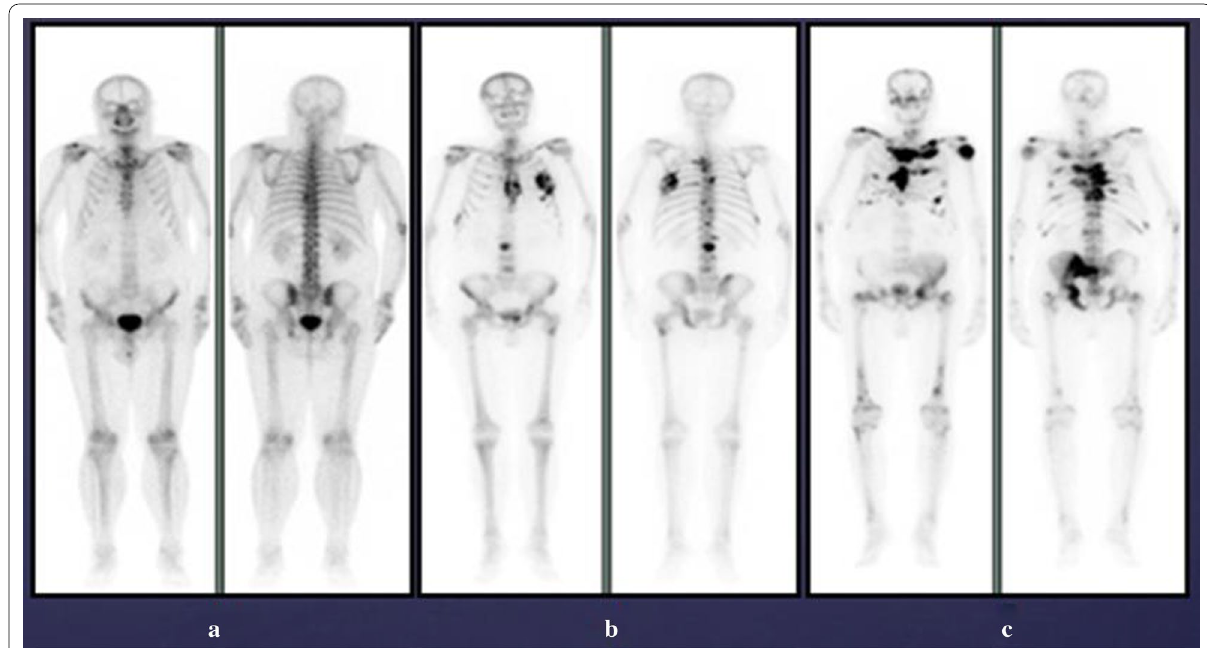
Fig. 1 Bone scintigraphy images of three prostate cancer patients at different stages. a: An example patient without bone metastases; free PSA: 2.53 ng/ml, total PSA:17.54 ng/ml, free/total PSA ratio: 0.144, ALP: 43 U/L, b: An example patient with numerous metastases; free PSA: 3.11 ng/ ml, total PSA:18.30 ng/ml, free/total PSA ratio: 0.169, ALP: 114 U/L. C: An example patient with multiple metastases; free PSA: 12.90 ng/ml, total PSA:121.20 ng/ml, free/total PSA ratio: 0.106, ALP: 109